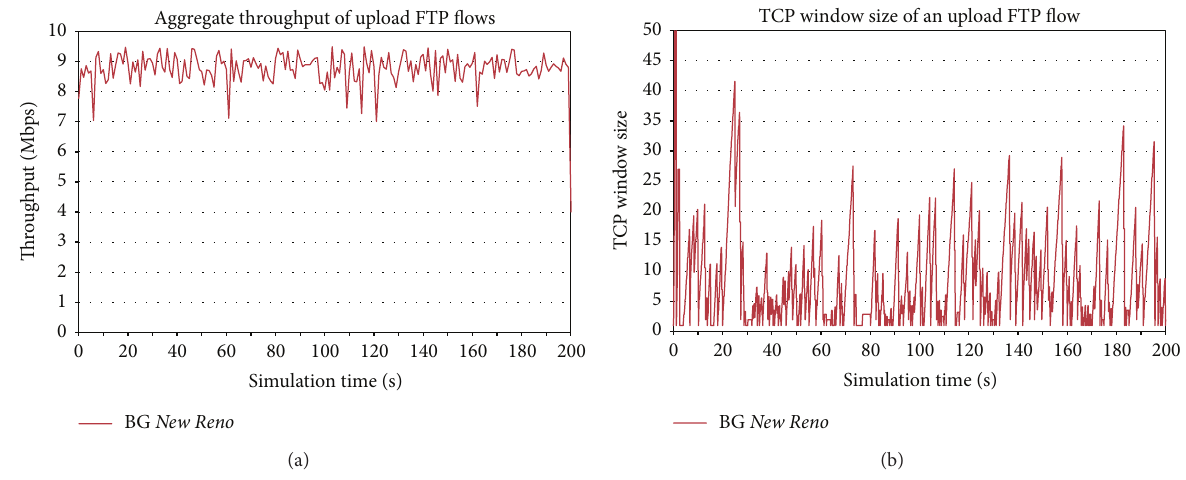
Figure 8: Competition between MMORPG and FTP background traffic using TCP New Reno : (a) aggregate throughput of the 10 FTP flows and (b) evolution of the TCP window of one of the flows.